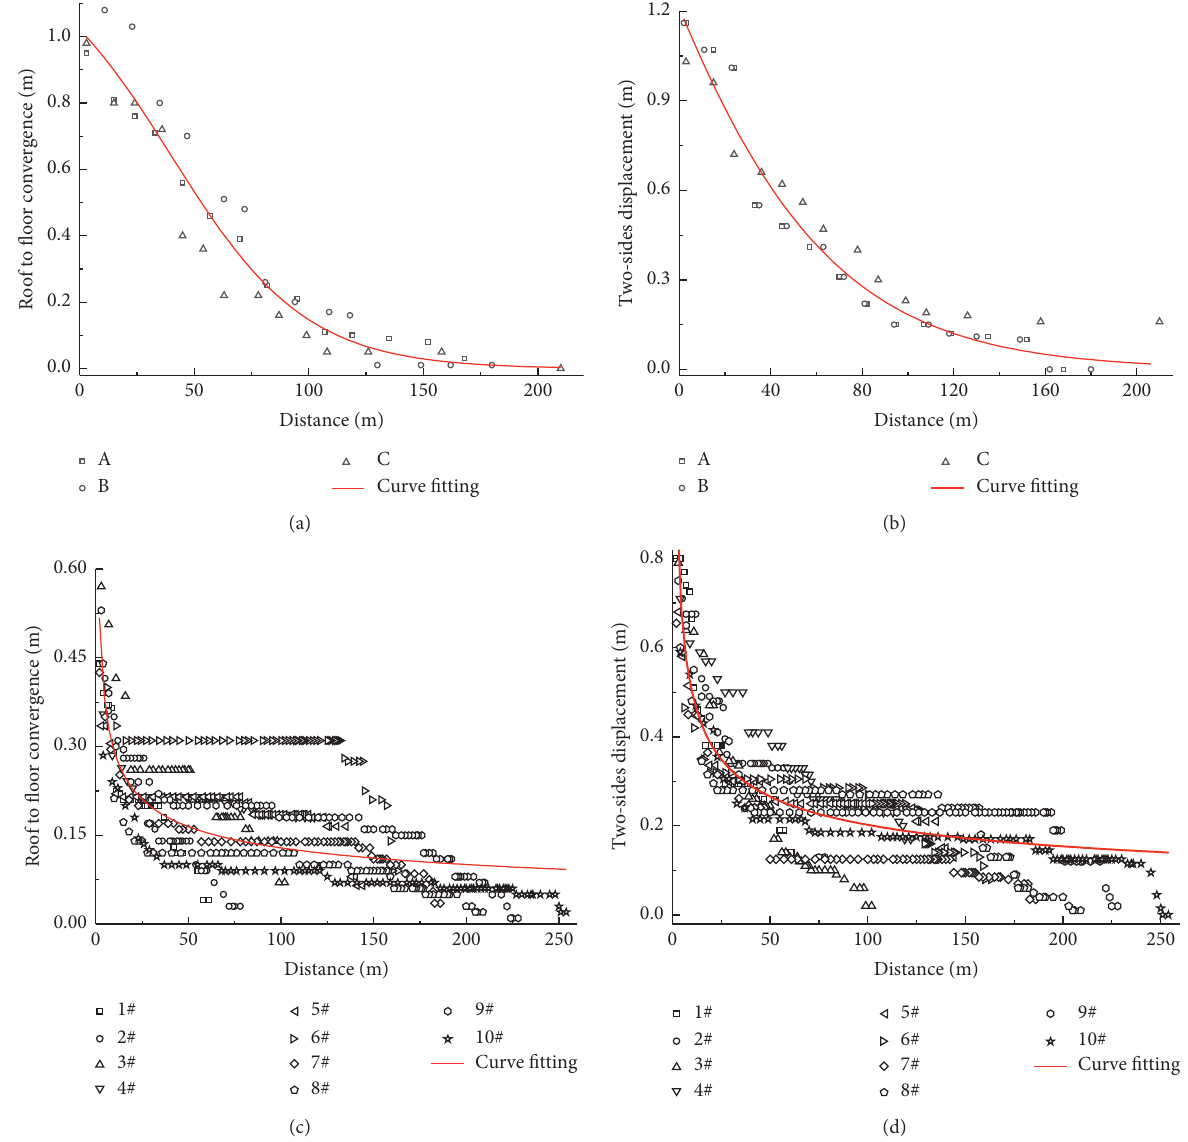
Figure 9: Comparison of roadway deformations in both fracturing area and nonfracturing area. (a) Results of the roof to floor convergence without fracturing. (b) Displacement of two sidewalls without fracturing. (c) Results of roof to floor convergence with fracturing. (d) Displacement of two sidewalls with